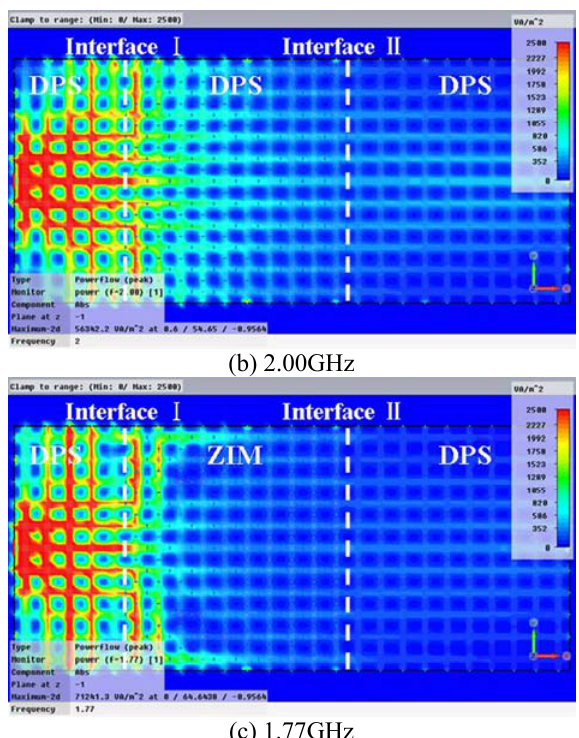
Figure 4: Amplitudes of power flow of the sample at different frequencies. (a) Amplitudes of power flow focused in the DNG region and the second DPS region in 1.25GHz. (b) Amplitudes of power flow are decaying away from the interface in 2.00GHz. (c) Amplitudes of power flow in the DPS/ZIM/DPS regions in